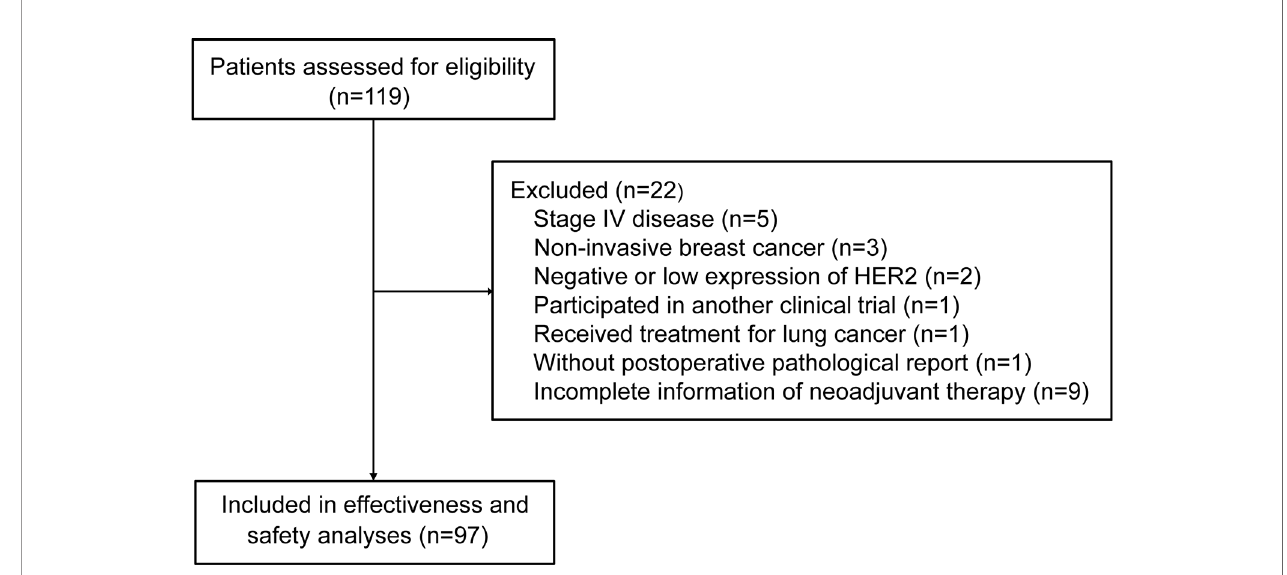
FIGURE 1 | Patient fl